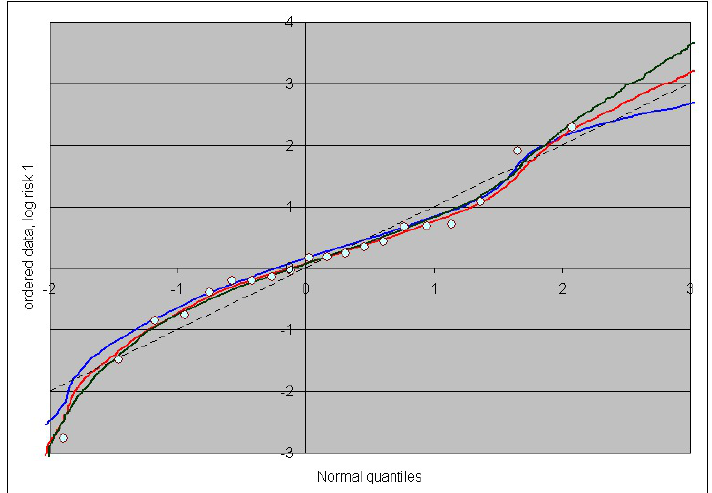
Figure 24. Q-Q-plot for the first risk, ordered log data.